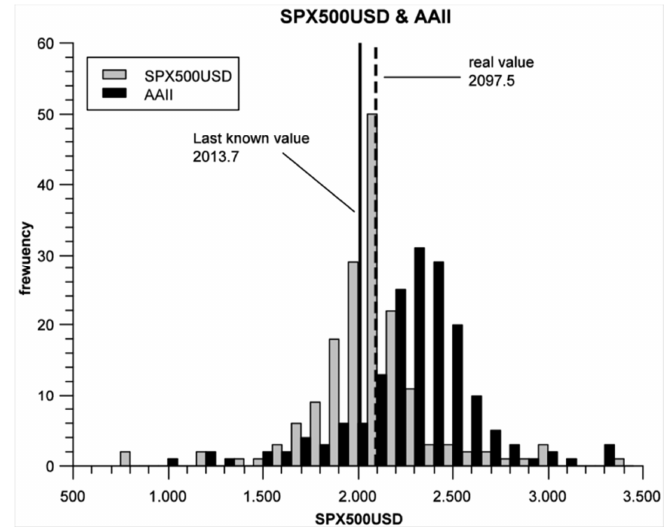
Figure 9. Combination of the SP500USD index and individual investors’ sentiment (AAII)